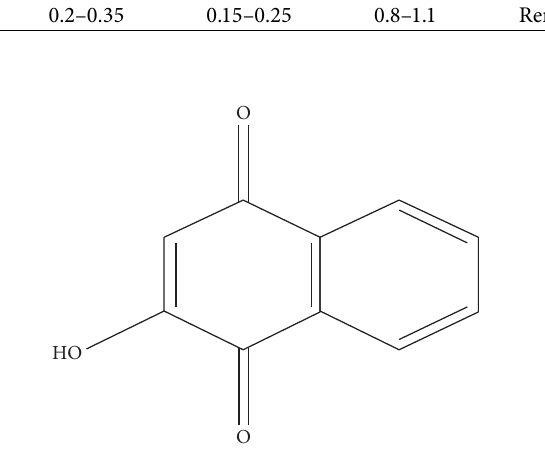
Figure 1: Structure of lawsone (central component) in Lawsonia